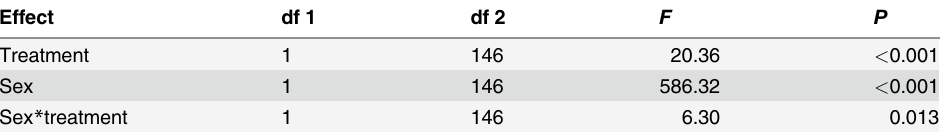
Table 3. Factorial ANOVA results of comparison of pupae weight between females and males reared on Betula pendula leaves with low and high concentrations of surface lipophilic compounds. Effect